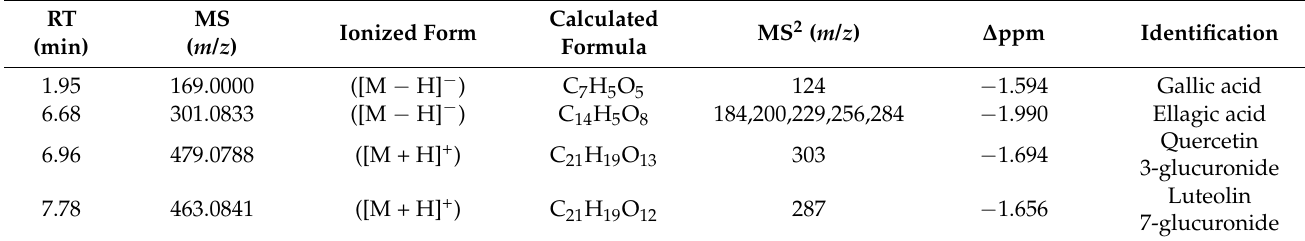
Table 2. Identification of four major ingredients in OBS-E using UHPLC-MS.